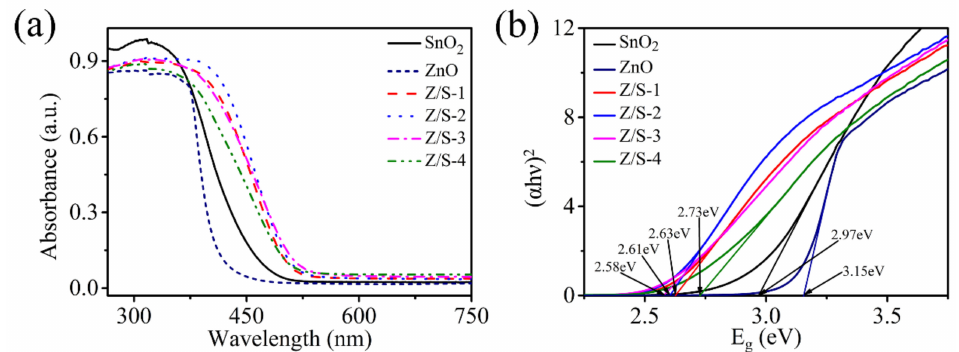
Figure 5. ( a ) UV-vis absorption spectra and ( b ) band gap energies of SnO 2 , ZnO, Z/S-1, Z/S-2, Z/S-3, and Z/S-4